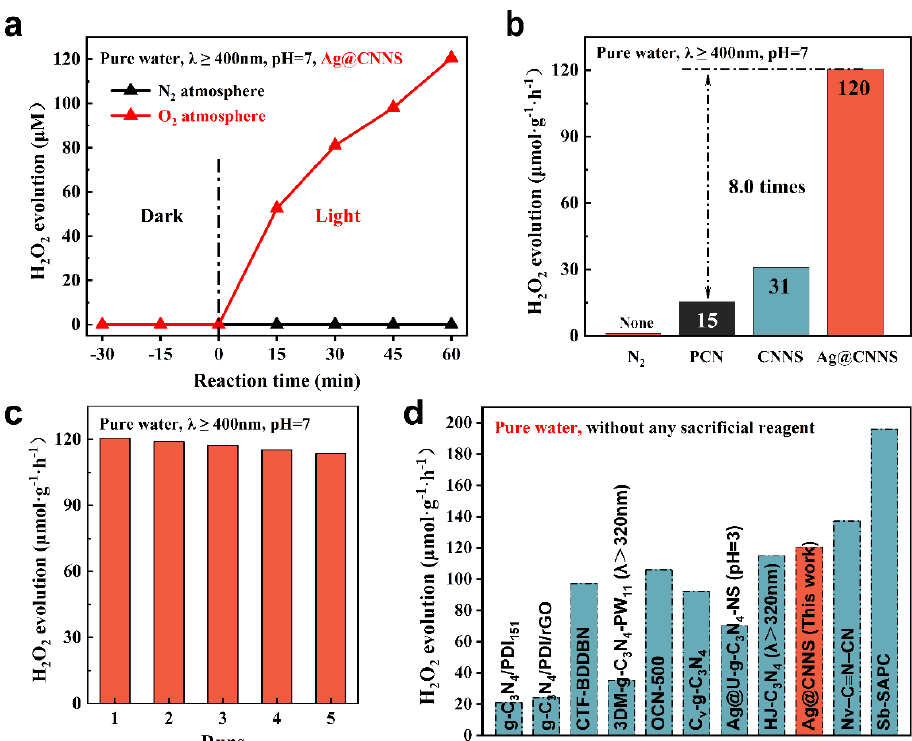
Figure 4. ( a ) H 2 O 2 yields of different times during the photocatalytic reaction; ( b ) the photocatalytic H 2 O 2 generation rates of different samples under visible-light irradiation; ( c ) cycling test of photo-